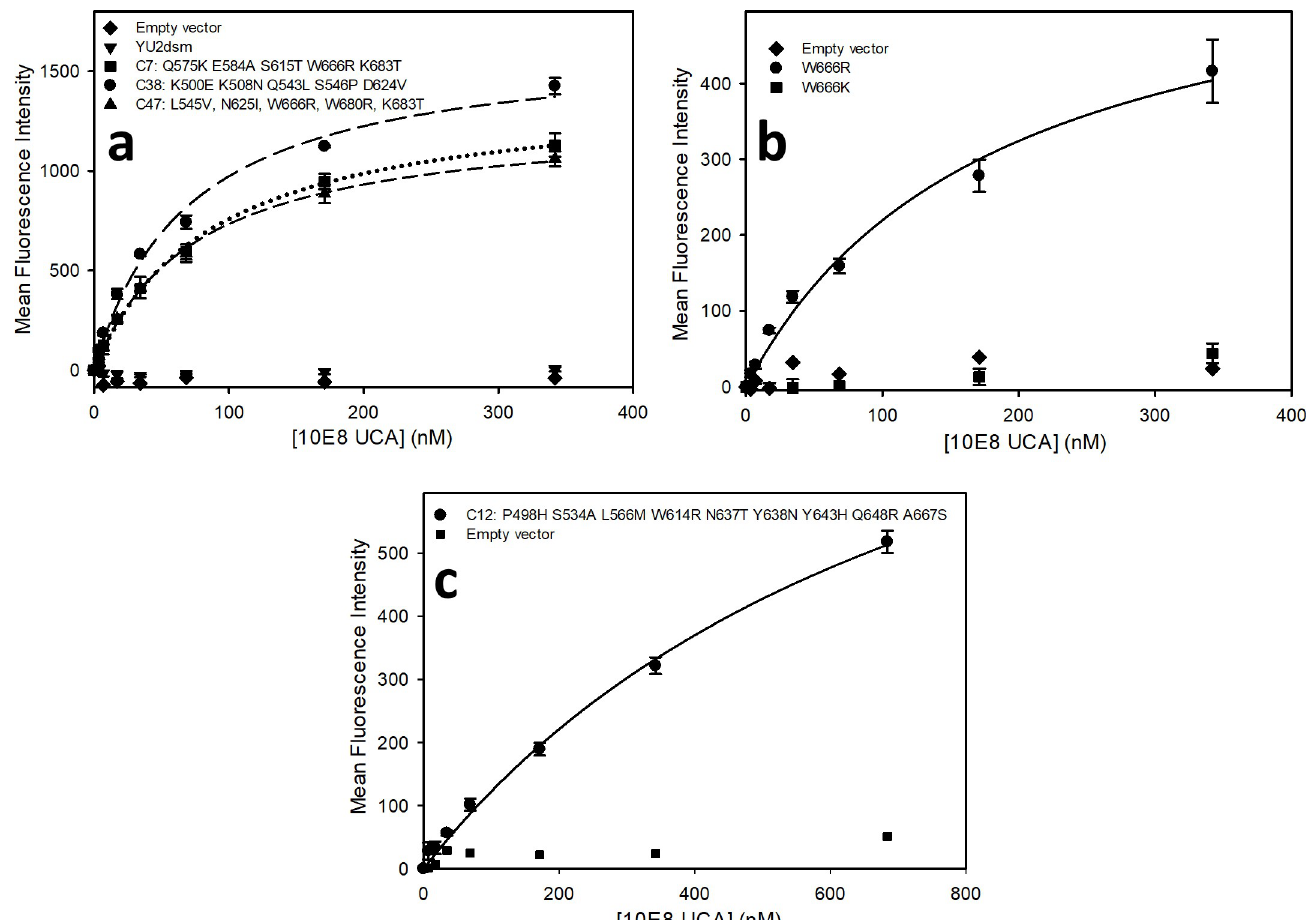
Fig 2. a) Saturation binding assay of 10E8 UCA to reconstructed YU2dsm Env variants corresponding to clones C7, C38, and C47 from 10E8 UCA-sorted library (containing the amino acid substitutions noted on figure). b) Saturation binding assay of 10E8 UCA to reconstructed YU2dsm Env variants carrying mutations W666R and W666K to 10E8 UCA. c) Saturation binding assay of 10E8 UCA to reconstructed library clone C12 lacking W666R but containing the substitutions P498H, S534A, L566M, W614R, N637T, Y638N, Y643H, Q648R, and